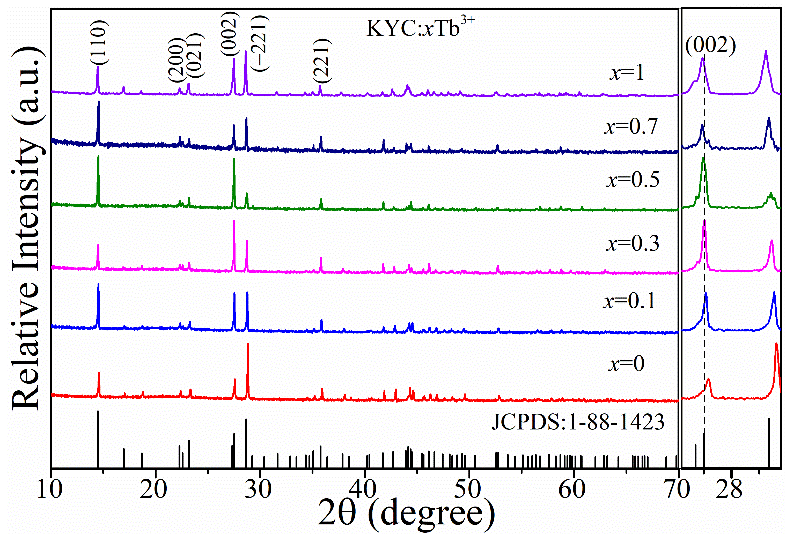
Figure 1. X-ray diffraction spectra of KYC:xTb 3+ ( x = 0, 0.1, 0.3, 0.5, 0.7, 1).